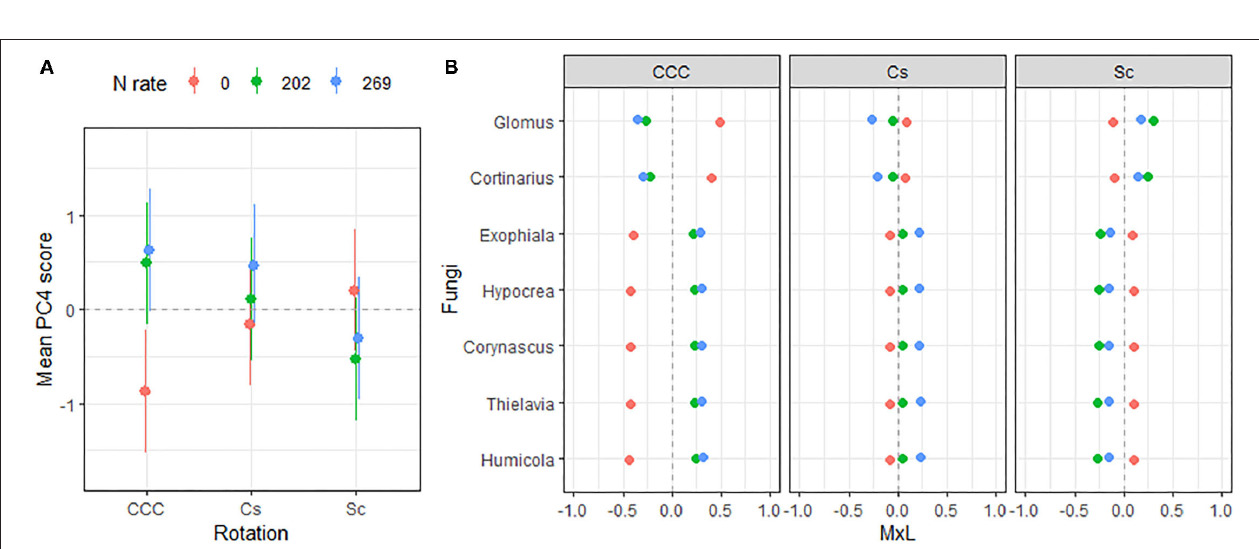
FIGURE 6 | (A) Mean value of the fungal PC4 scores for each rotation at each level of N fertilization. Standard errors are indicated as whiskers. (B) Contribution of each indicator genera to the PC mean value (MxL) for each rotation (panels) at each level of N fertilization: CCC, continuous corn; Cs, corn phase of the corn-soybean rotation; Sc, soybean phase of the corn-soybean rotation.